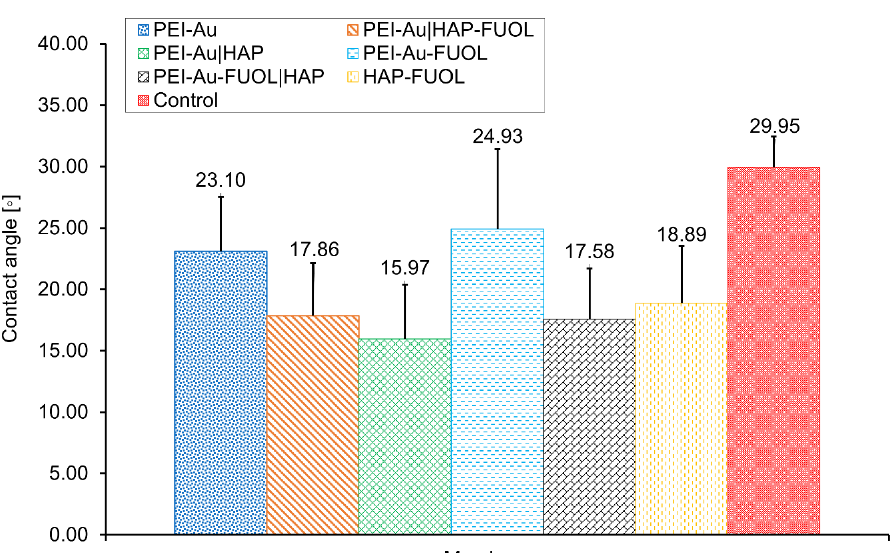
Figure 1. The water contact angle of the composite membranes. Key to the symbols: PEI-Au— polyethylenimine incorporating gold nanoparticles; PEI-Au-FUOL—polyethylenimine incorporating gold nanoparticles and fullerenol, hydroxyapatite mixed with FUOL; bilayered: PEI-Au|HAP— polyethylenimine incorporating gold nanoparticles and hydroxyapatite; PEI-Au|HAP-FUOL— polyethylenimine incorporating gold nanoparticles, and hydroxyapatite incorporating FUOL; PEI- Au-FUOL|HAP—polyethylenimine incorporating gold nanoparticles and FUOL layer and hydrox- yapatite layer. The values are presented as mean ± SD.